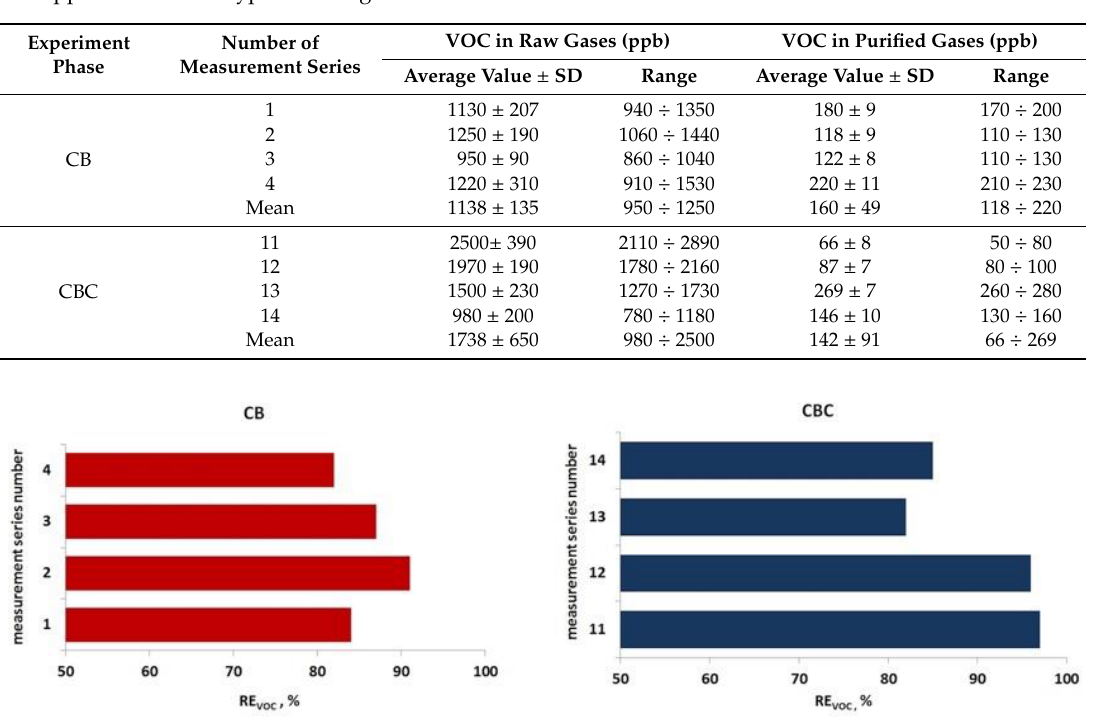
Figure 5. Mean e ff ectiveness of VOC removal in subsequent measurement series of single-stage Figure 5. Mean effectiveness of VOC removal in subsequent measurement series of single-stage biofiltration for both biofiltration for both fillings.